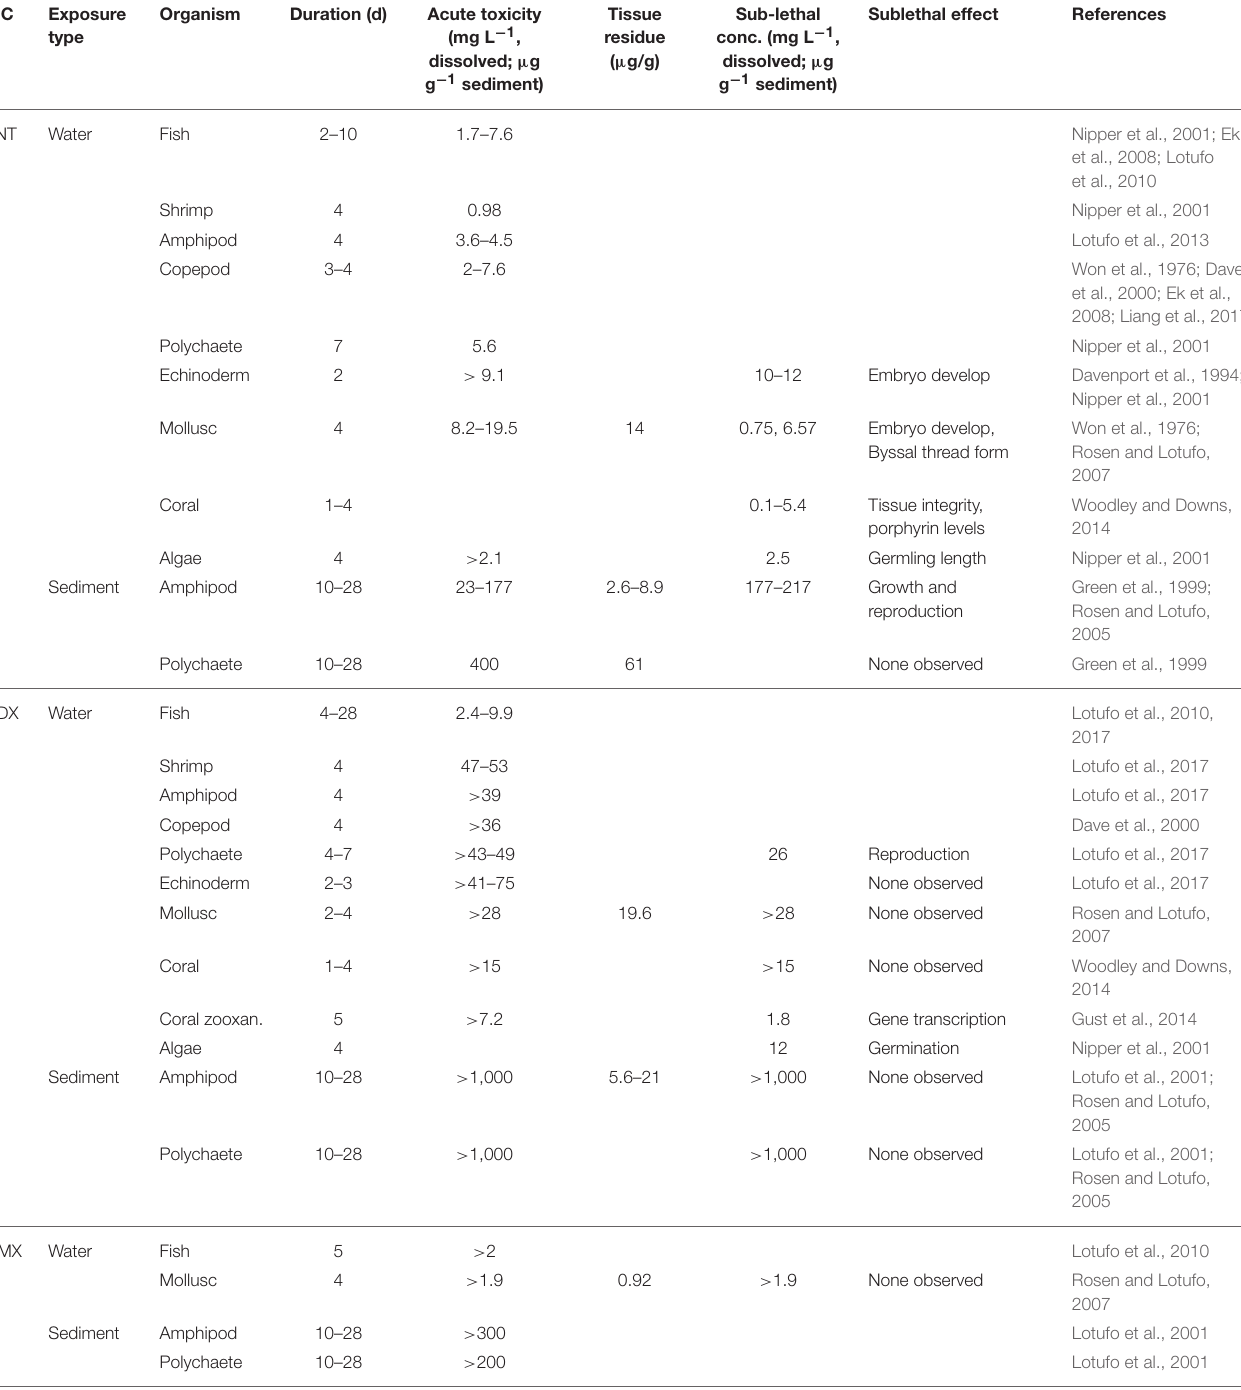
TABLE 5 | Acute and sublethal toxicity of TNT, RDX, and HMX to marine organisms.